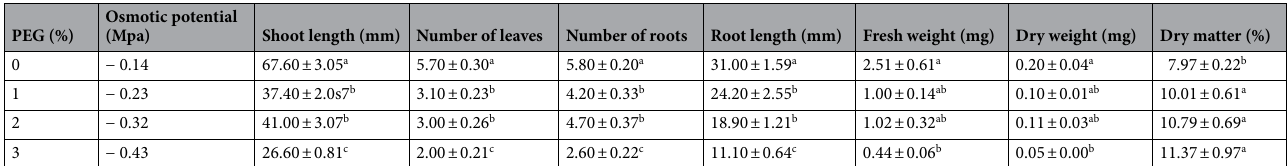
Table 1. Effect of different PEG 6000 concentrations on the in vitro growth of Vanilla planifolia . Values represent the mean ± SE (standard error) at 60 days of culture. Means with different letters are significantly different (Tukey, p ≤